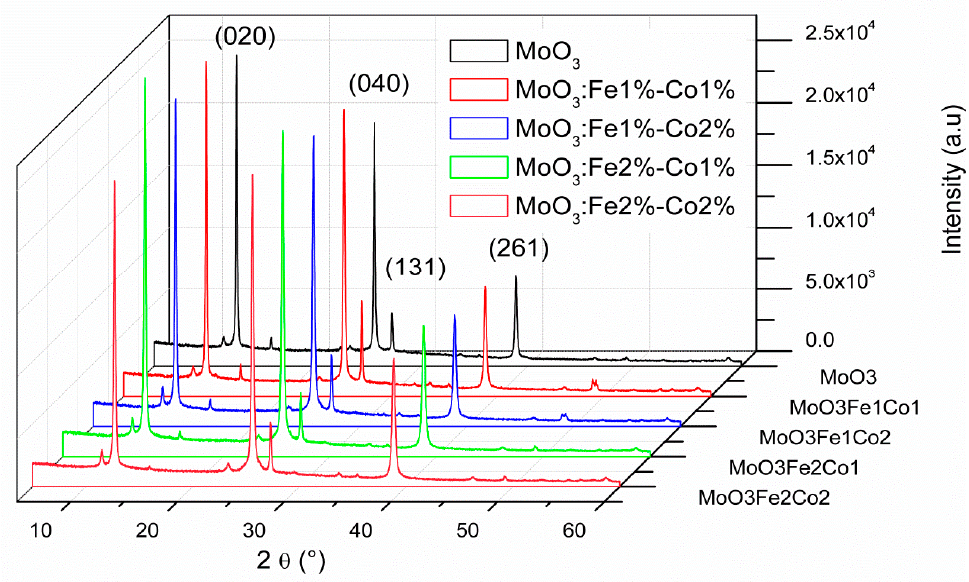
Figure 1. X-ray diffraction patterns of (Co,Fe)-doped MoO 3 thin films.